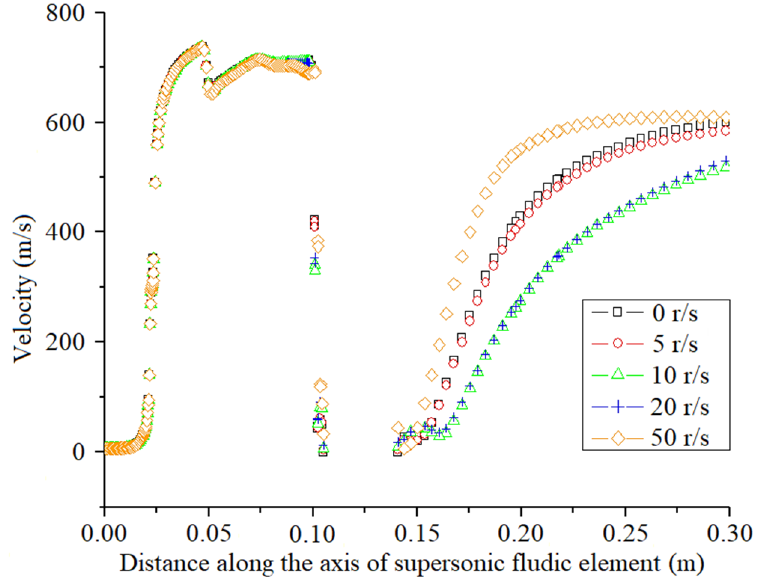
Figure 17. Velocity distribution along the symmetrical axis of supersonic fluidic elements at different rotational angular velocities.